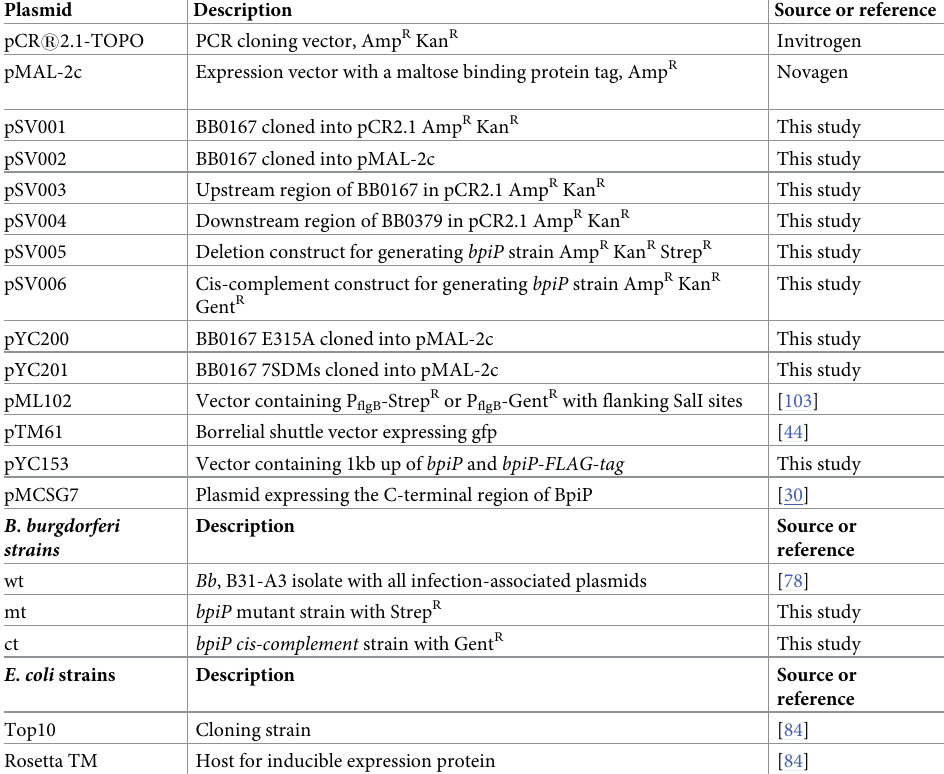
Table 4. Plasmids and strains used in this study. Plasmid